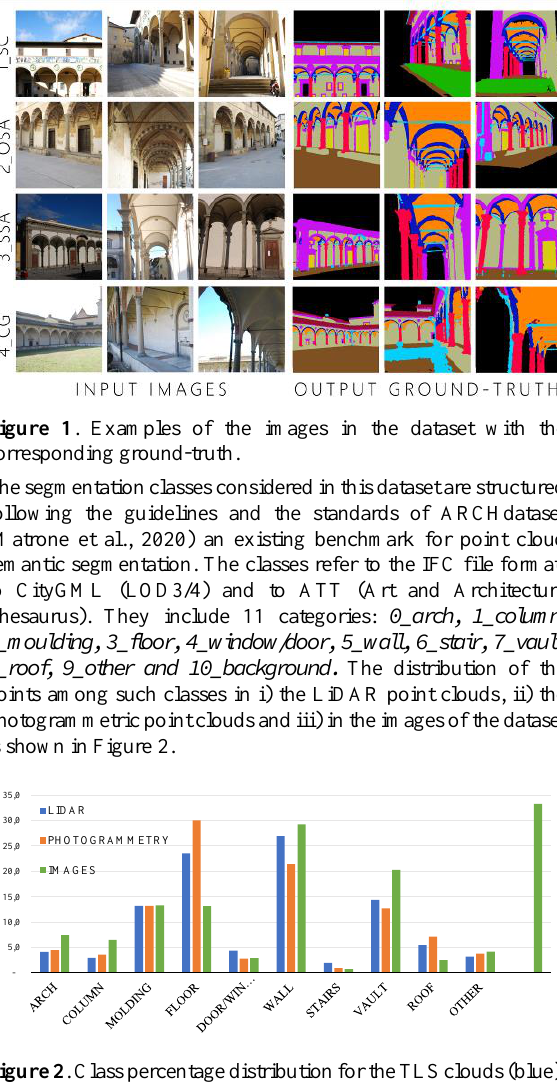
Figure 2 . Class percentage distribution for the TLS clouds (blue), for the photogrammetric clouds (orange), and for the images (green).